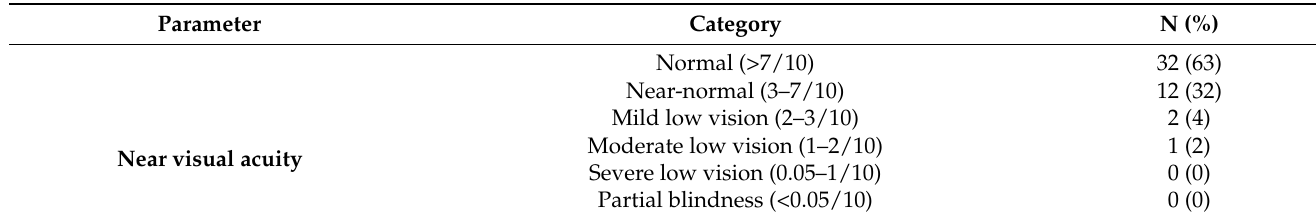
Table 2. Visual function (perceptual and oculomotor) characteristics of the